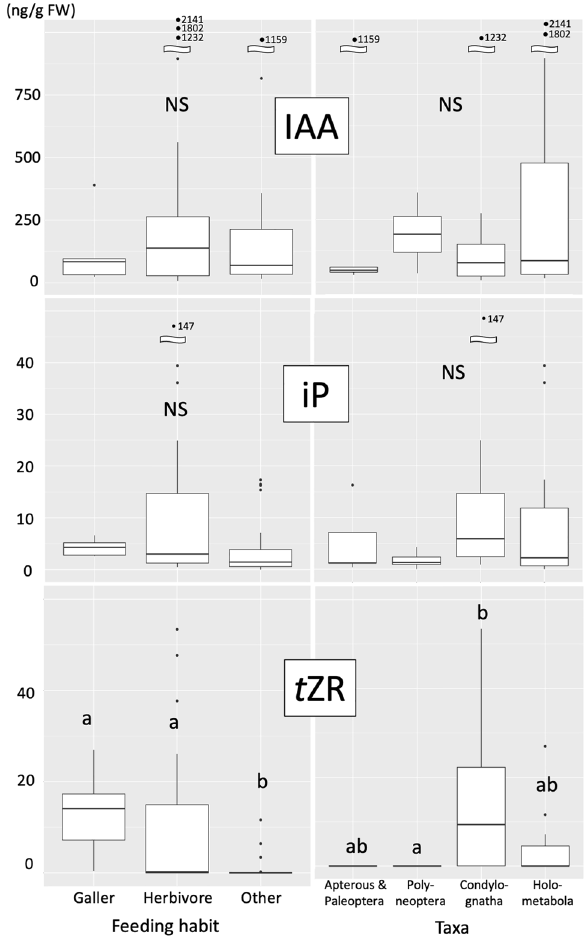
Figure 3. Comparison of endogenous concentrations of auxin (indole-3-acetic acid, IAA), isopentenyladenine (iP), and trans -zeatin riboside ( t ZR) among different taxa and feeding habits (gallers, non-galling herbivores and others) of terrestrial insects. The same letters above bars indicate no significant differences among groups